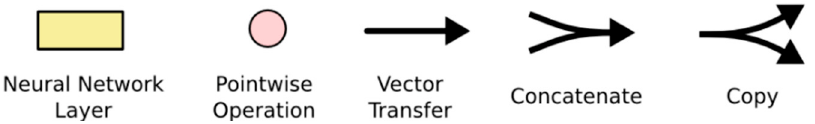
Figure 4. The repeating module in an LSTM contains four interacting layers.